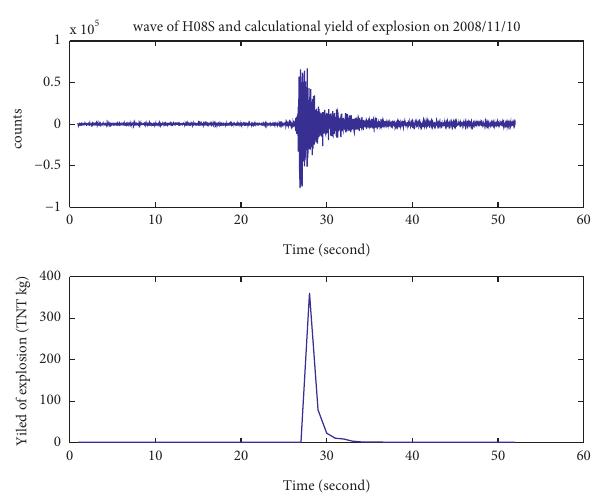
Figure 4: Equivalent estimation monitoring threshold trace in 90% probability of H08S station.